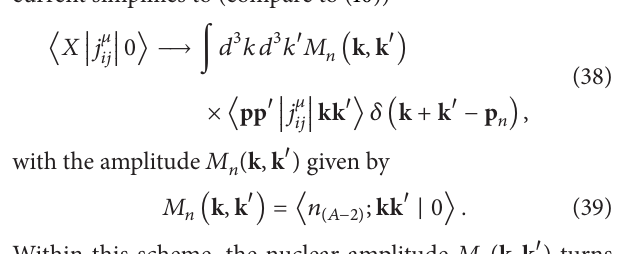
Figure 7: Comparison between the flux averaged muon energy spectra measured by the MiniBooNE collaboration at muon scattering angle 0.8 ≤ cos 𝜃 ≤ 0.9 (a) and 0.3 ≤ cos 𝜃 ≤ 0.4 (b) [5] and the results of the approach of [48]. The data, with their error bars, are 𝜃 𝜇 such that 𝜇 𝜇 represented by the boxes, while the solid lines show the calculated